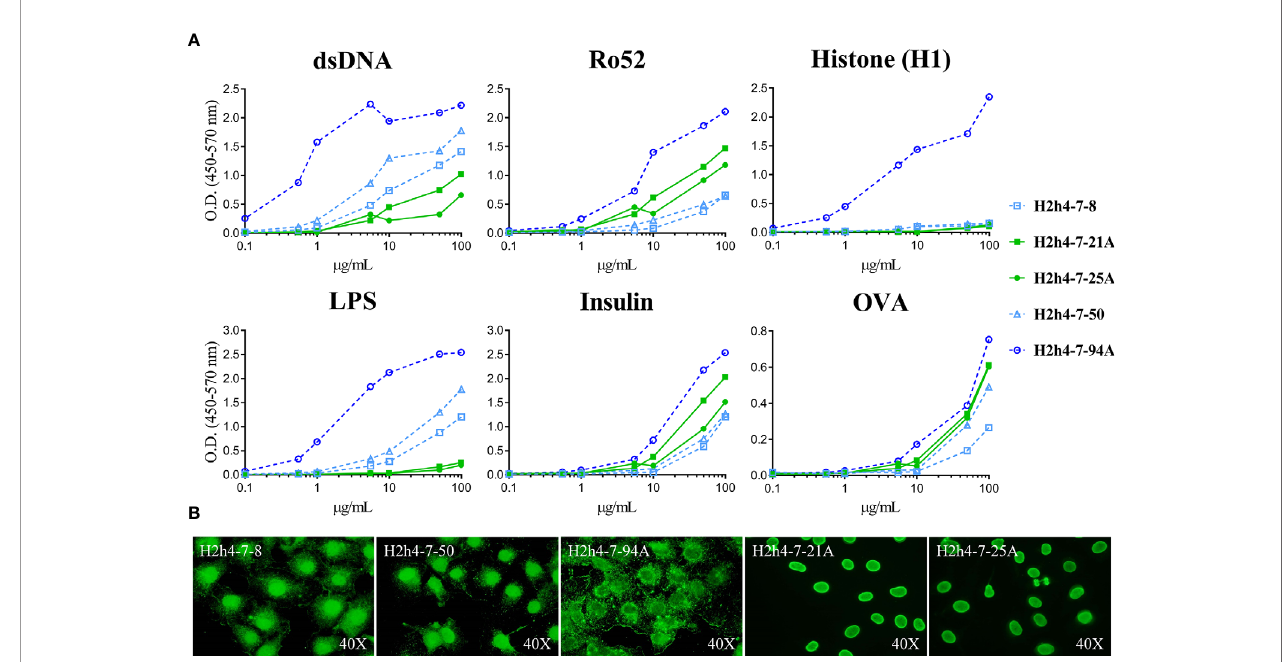
FIGURE 6 | Antigen reactivity strength of polyreactive antibodies. The antigen reactivity strength of polyreactive antibodies (H2h4-7-8, H2h4-7-21A, H2h4-7-25A, H2h4-7-50 and H2h4-7-94A) to dsDNA, H1, Ro52, LPS, Insulin and OVA was determined by ELISA (ranging from 100 m g/mL - 0 ’ 01 m g/mL) (A) . Antibodies sharing the same IGHV and IGKV sequences are represented with the same color (blue or green); H2h4-7-94A represented in dark blue has additional mutations compared to H2h4-7-8 and H2h4-7-50 represented in light blue. Representative images of immunocytochemistry with HEp-2 cells showing the cellular patterns of each antibody (B)